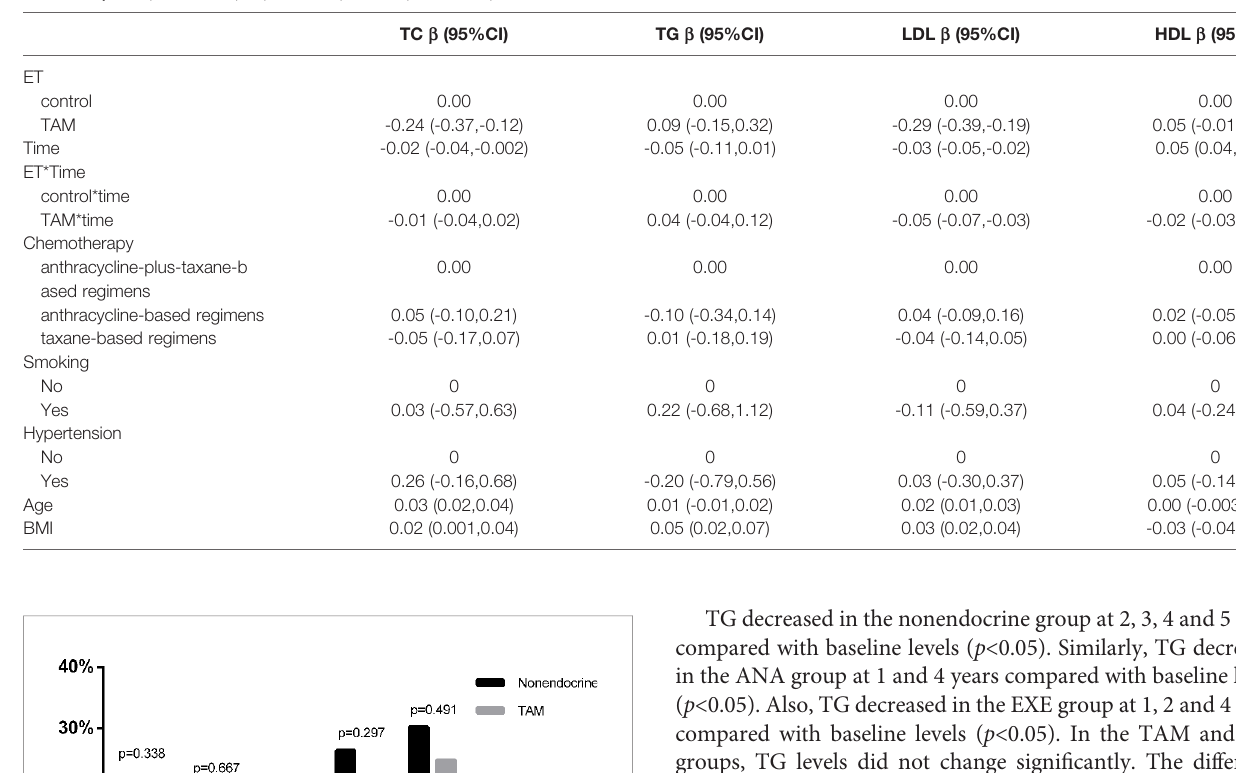
TABLE 3 | Comparison of lipid pro fi les in premenopausal BC patients.